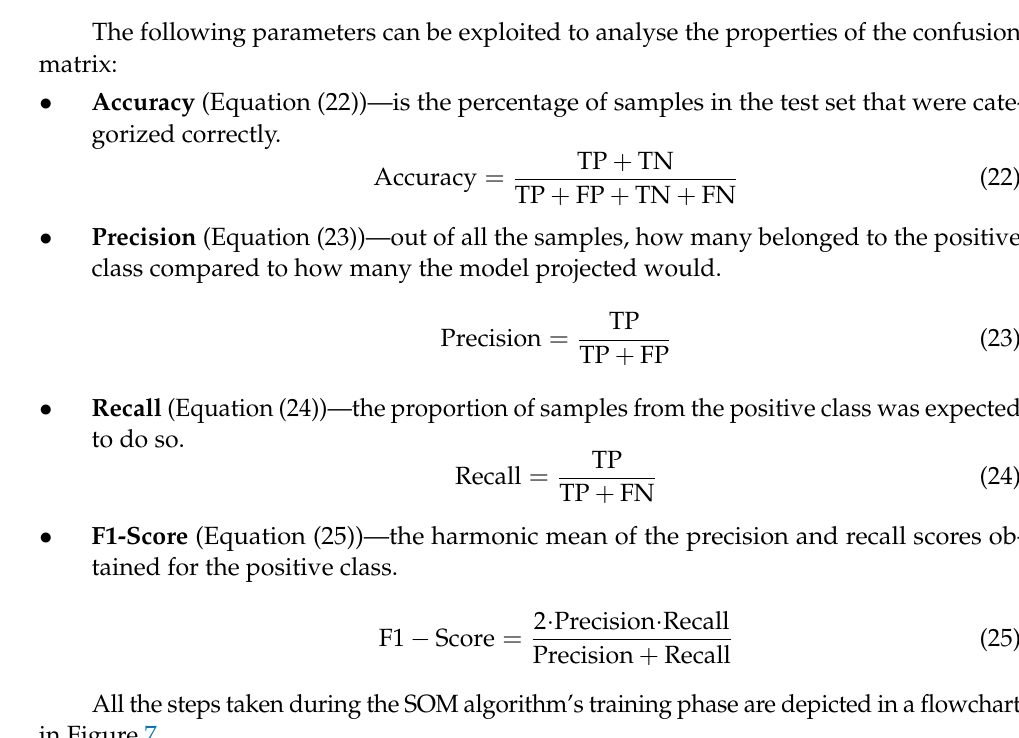
Figure 6. Confusion matrix for the binary classification [51].